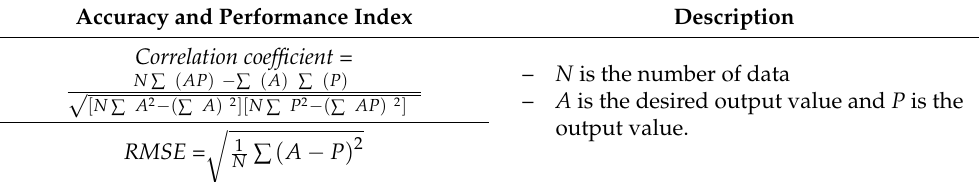
Table 3. Model evaluation metrics.